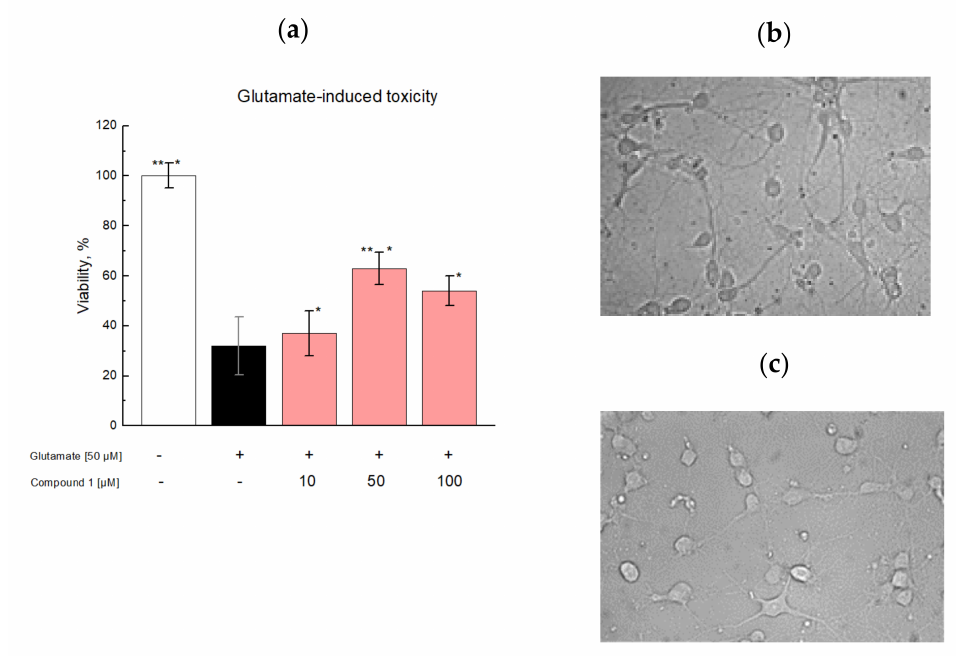
Figure 1. ( a )—compound 1 effects on glutamate-mediated neurotoxicity in a primary newborn rat cortical neuron culture. Newborn Wistar rat cortical neurons were cultured with glutamate for 24 h and afterward treated with 10 µ M, 50 µ M, 100 µ M of compound 1 ; after 24 h, 3(4,5-dimethylthiazol-2- yl)-2.5-diphenyltetrazolium bromide (MTT) assay was used to assess the cell viability. * A significant difference compared with the glutamate-free control, P < 0.05. ** A significant difference compared with the glutamate control, P < 0.05. The results are expressed as the mean ± standard error of the mean for three independent experiments ( n = 8). The data were normally distributed according to Kolmogorov–Smirnov test. One-way ANOVA was used; ( b )—cortical neurons before glutamate treatment; ( c )—cortical neurons after treatment with glutamate 24